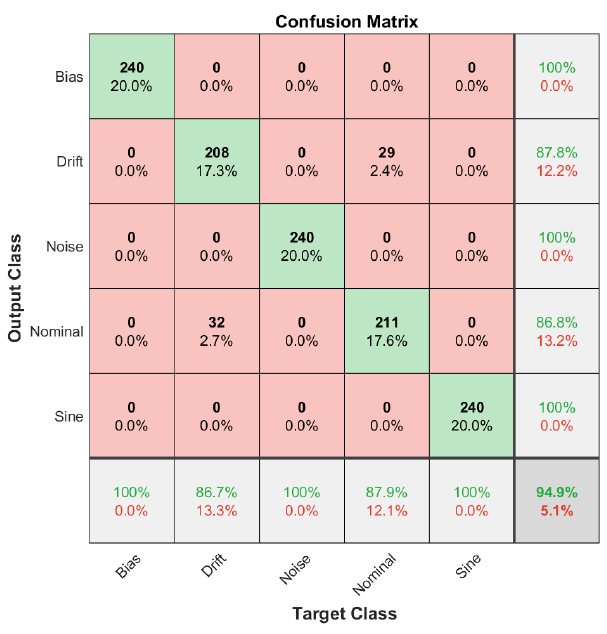
Figure 12. Confusion matrix for the training data set showing that a huge proportion of the misclassi- fied samples are between drift fault and nominal scenarios.